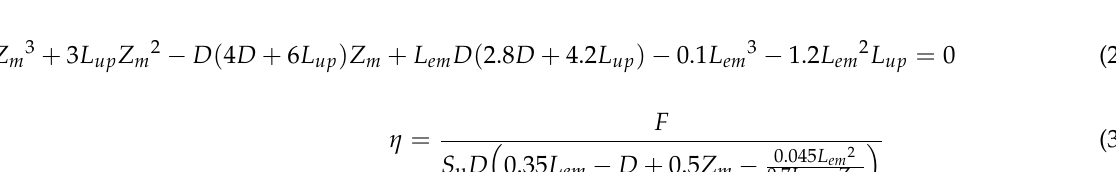
Figure 4. Assumed soil lateral reaction profile .